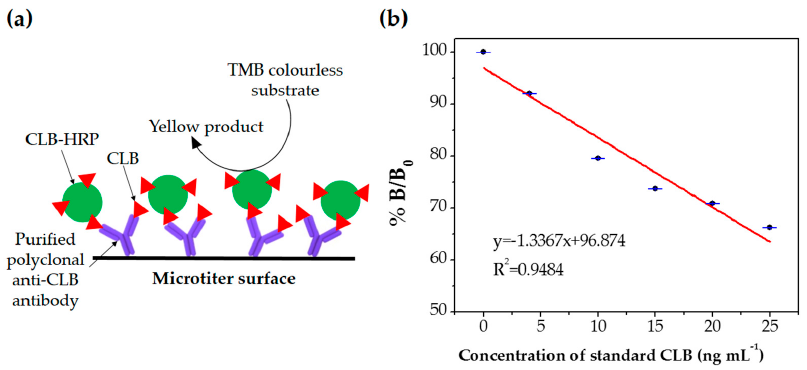
Figure 5. ( a ) Schematic diagram of detection principle using direct competitive ELISA; ( b ) ELISA standard CLB using direct competitive immunoassay.